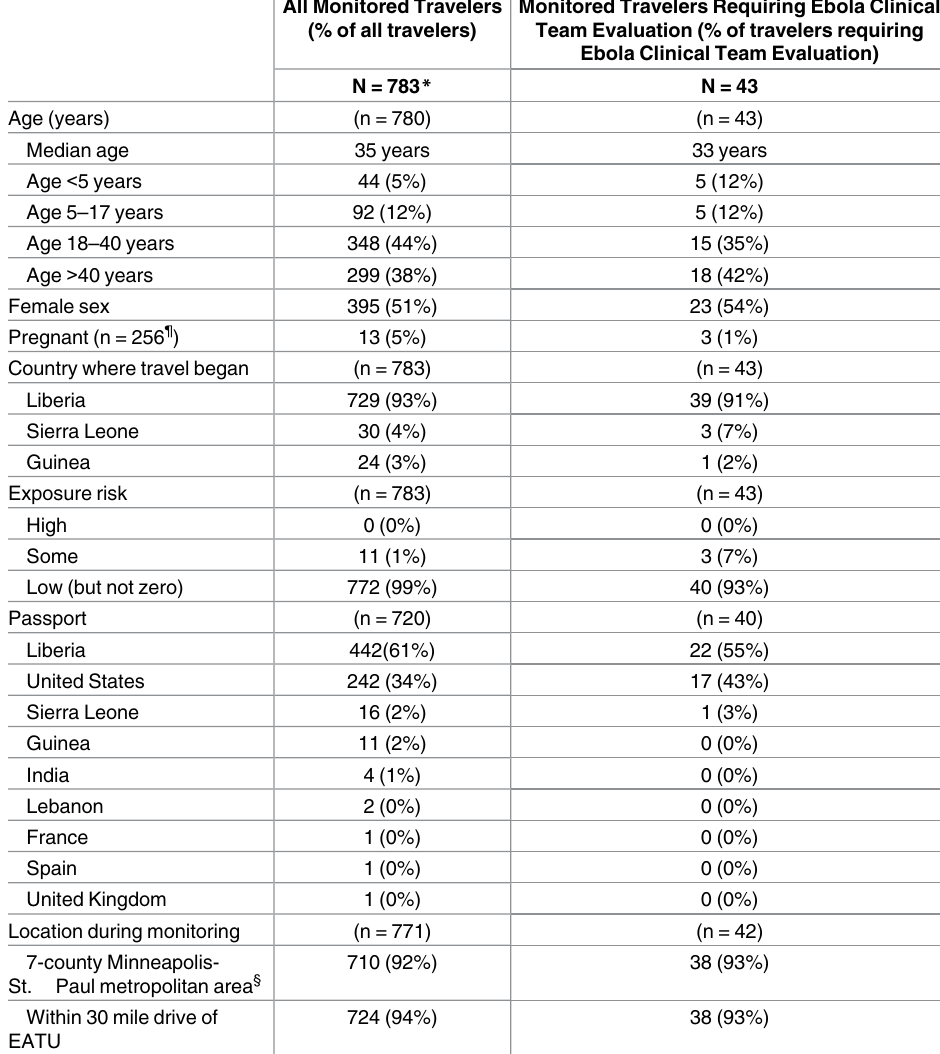
Table 1. Demographics of Monitored Travelers—Minnesota, October 21, 2014–May15, 2015. All Monitored Travelers Monitored Travelers Requiring Ebola Clinical (% of all travelers) Team Evaluation (% of travelers requiring Ebola Clinical Team Evaluation) N = 783